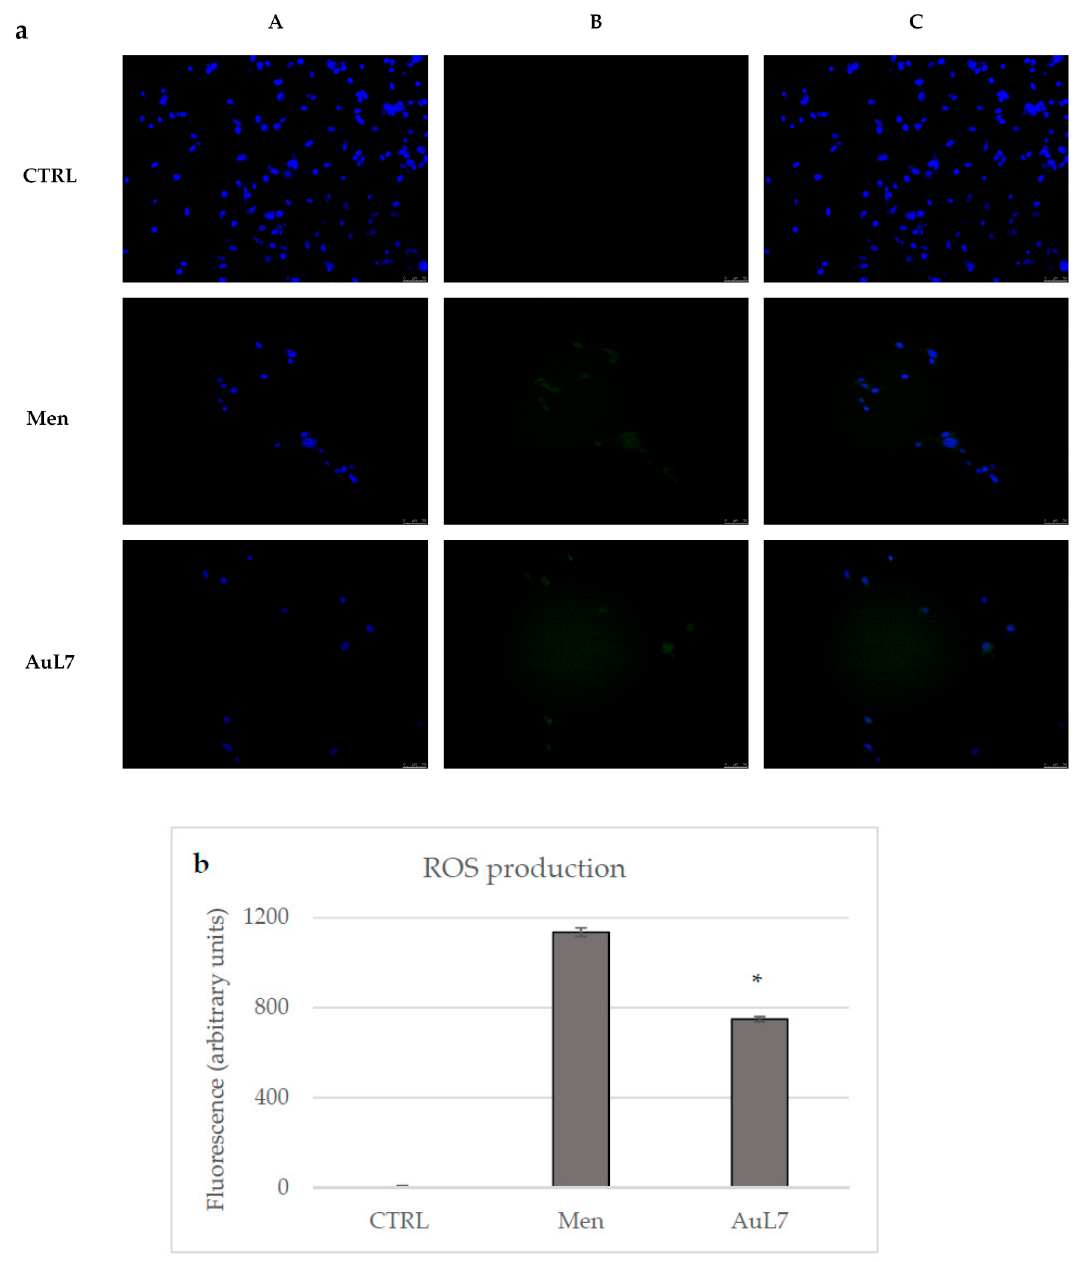
Figure 10. ROS induction by AuL7 treatment in MDA-MB-231 cells. ( a ) ROS production was evaluated by using DCF-DA in MDA-MB-231 cells treated with Menadione (Men, used as positive control), AuL7 , or vehicle. Images were acquired at 20 × magnification. ( A ): Nuclear stain with DAPI (excitation / emission wavelength 350 nm / 460 nm) in treated (Men or AuL7 ) and untreated cells (vehicle, CTRL); ( B ): DCF (excitation / emission wavelength 490 nm / 515 nm for CFQ488A) in treated (Men or AuL7 ) and untreated cells (vehicle, CTRL); ( C ): overlay channel; ( b ) Fluorescence quantification. * p < 0.001, AuL7 vs. Men. Fields are representative of three separate experiments. Our data indicate that AuL7 can increase the oxidative stress in MDA-MB-231 cells, an event related to the above-observed